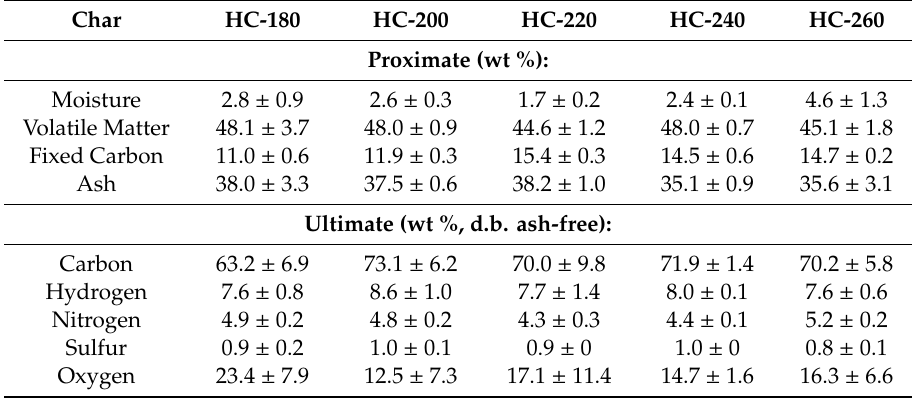
Table 2. Proximate and ultimate analysis of